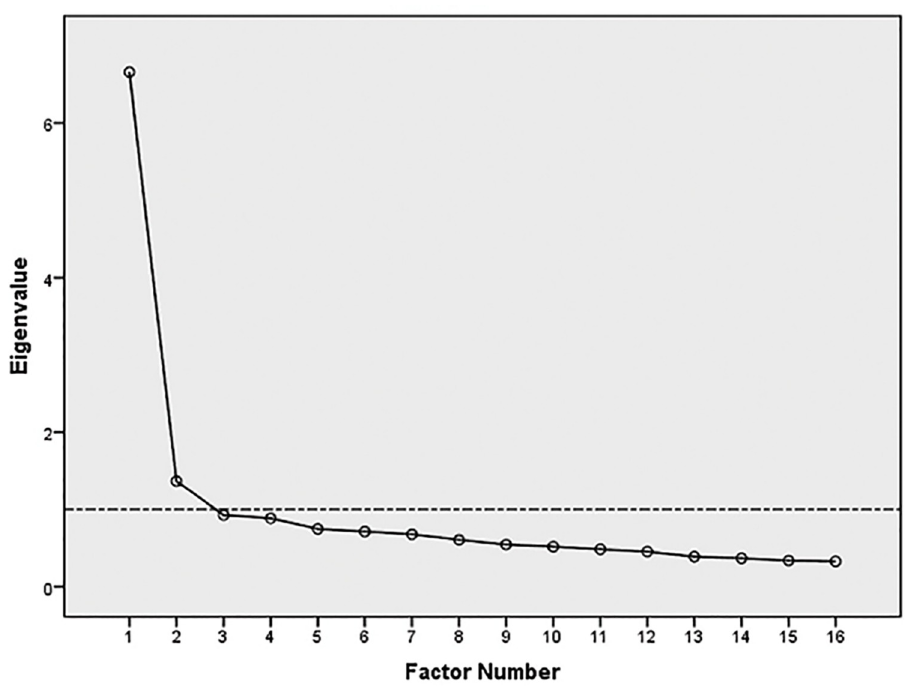
Fig 1. Scree plot of EFA for the 16-item CBI.